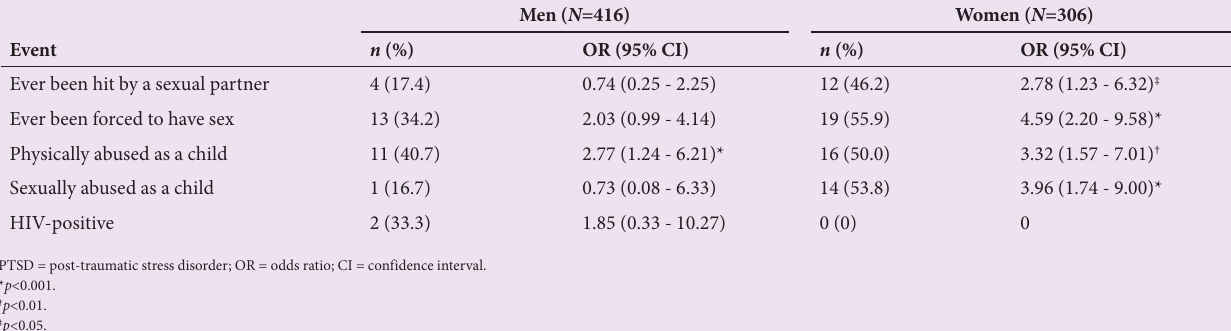
Table 3. Logistic regression analyses predicting a positive screen for depression Men ( N =416) Women ( N =306) Event n (%) OR (95% CI) n (%) OR (95% CI) Ever been hit by a sexual partner 15 (65.2) 3.46 (1.43 - 8.37) † Ever been forced to have sex 22 (57.9) 18 (66.7) 2 (33.3) 3 (50.0) 2.60 (0.23 - 28.99) OR = odds ratio; CI = confidence interval. * p <0.001.